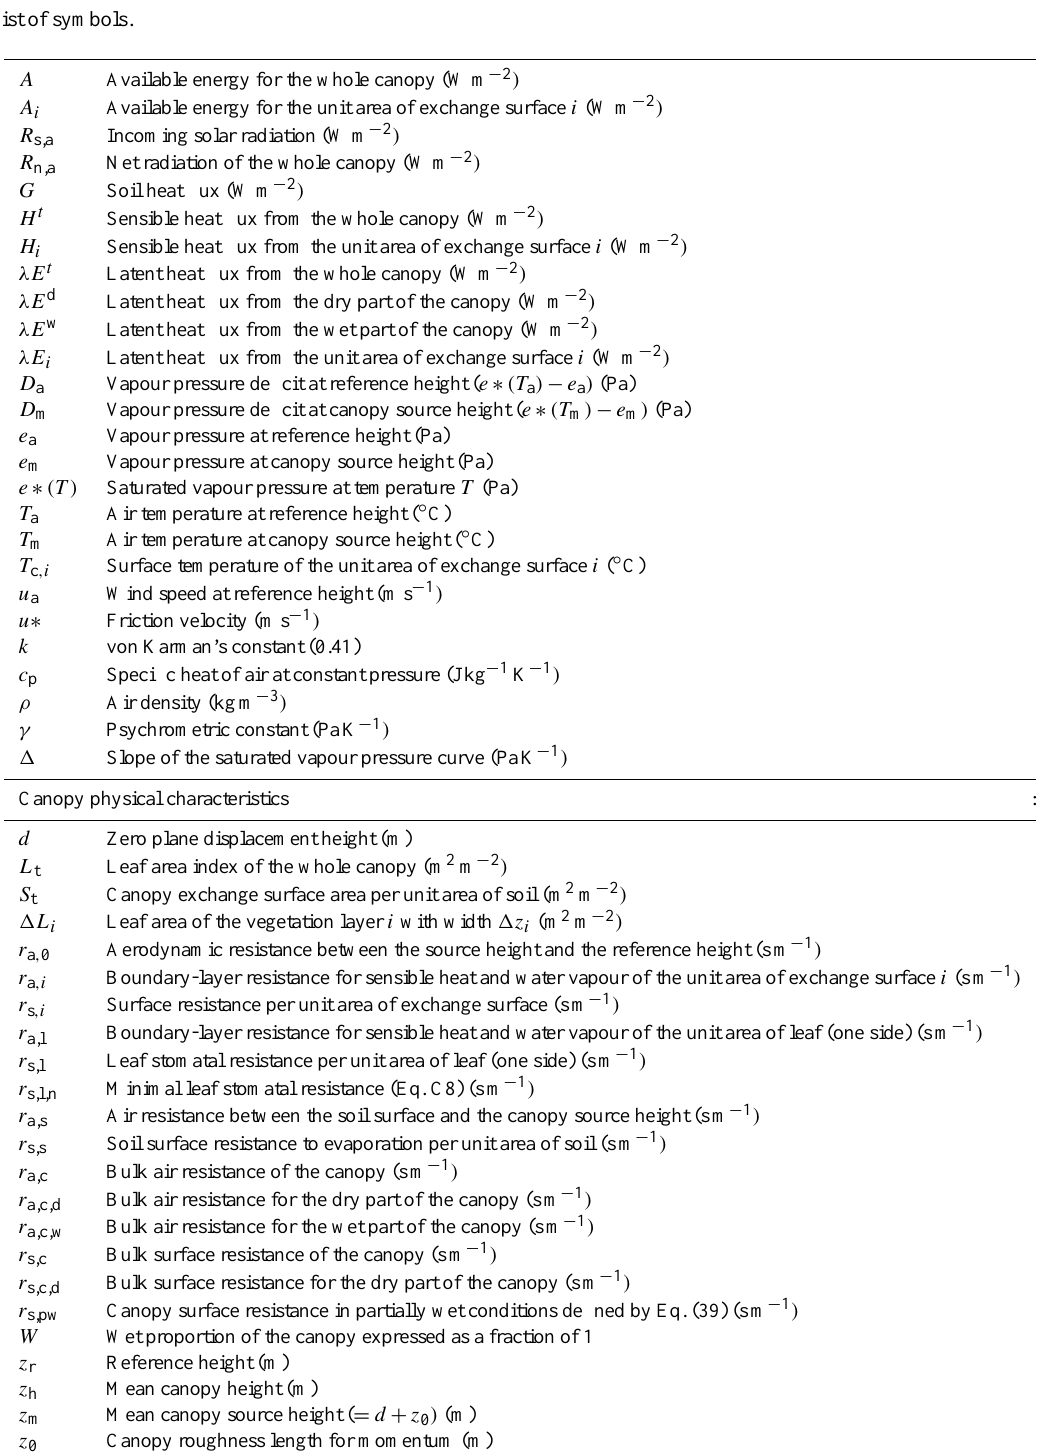
Table A1. List of